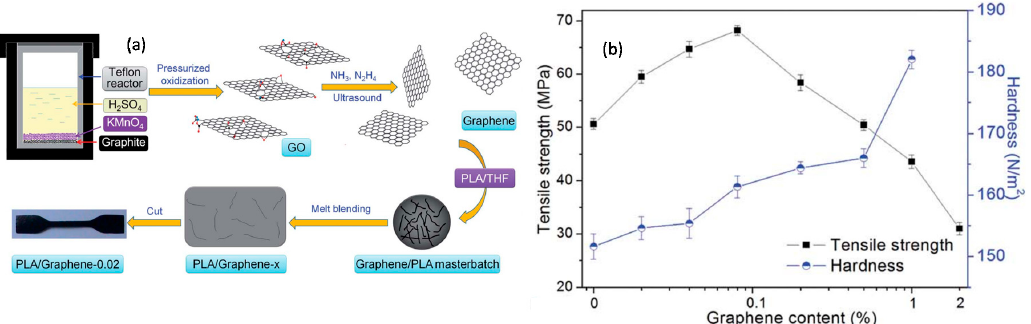
Figure 19. ( a ) Illustration for the preparation of graphene and PLA/graphene nanocomposites. The graphite is oxidized by pressurized oxidization and then reduced to single-atom-thick graphene by a multiplex reduction method. The graphene/PLA masterbatch (20% graphene) is prepared by solvent blending from PLA and graphene in THF media. The ‘‘x’’ in ‘‘PLA/Graphene-x’’ is the percentage of the graphene. The black sample is PLA/graphene-0.02 which contains 0.02% grapheme; ( b ) Tensile strength and hardness [77].